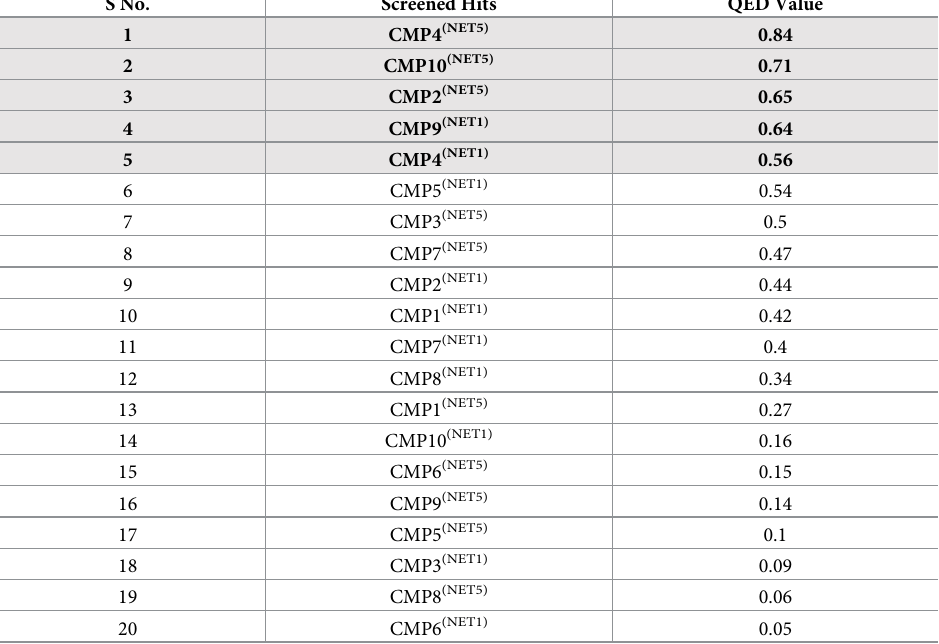
Table 4. Top 20 compounds screened using NET1 and NET5 model, further ranked on QED score. Top 5 com- pounds (highlighted grey) were selected for next phase of docking and simulation. S No. Screened Hits QED